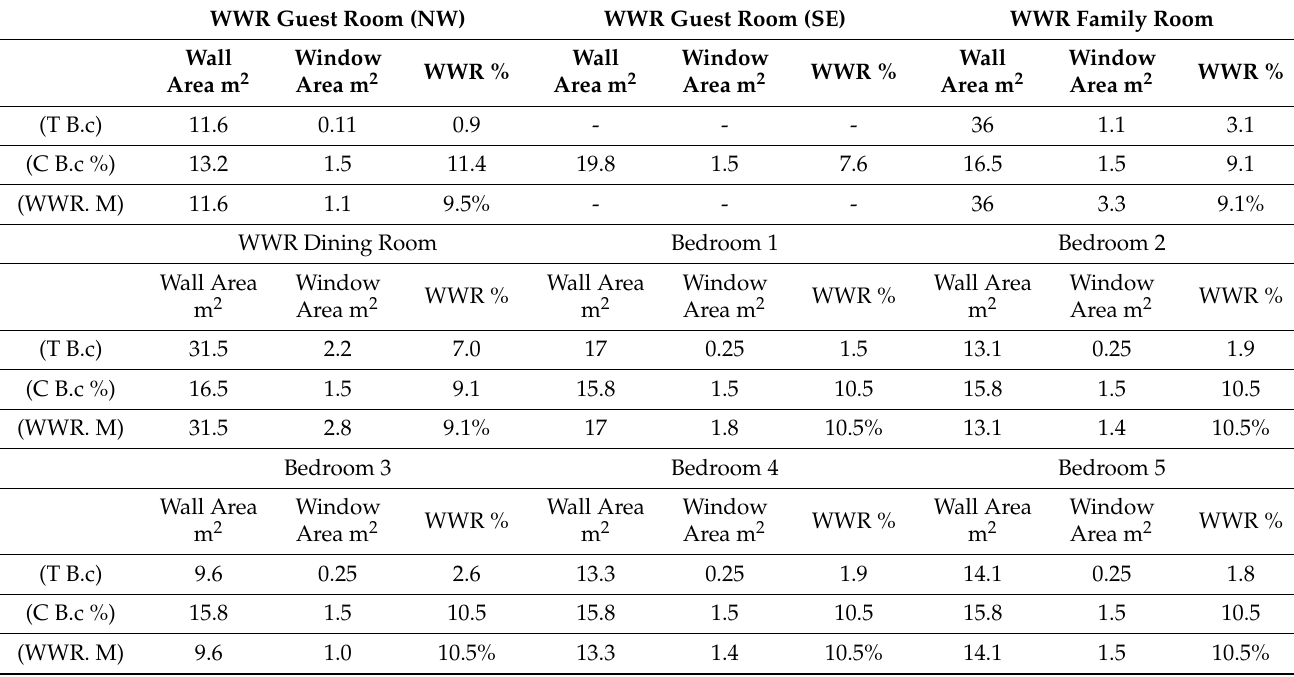
Table 3. The modification of WWR in traditional house in Hail city Case